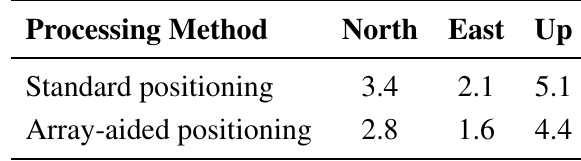
Table 5. Empirical position standard deviation (mm) for baseline estimation using the epoch-by-epoch processing of the static data (20-m